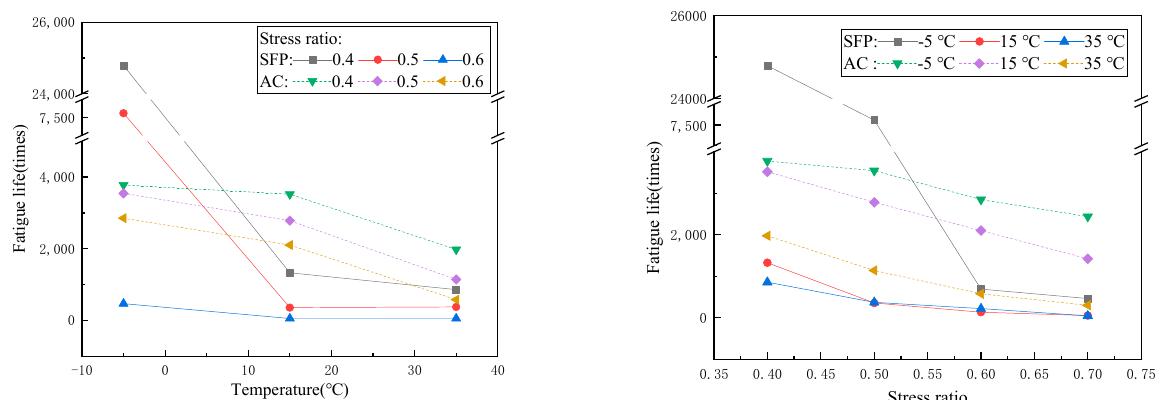
( b ) Variation trend of fatigue life with stress ratio. Figure 6. Fatigue life comparison of AC and SFP. Figure 6. Fatigue life comparison of AC and